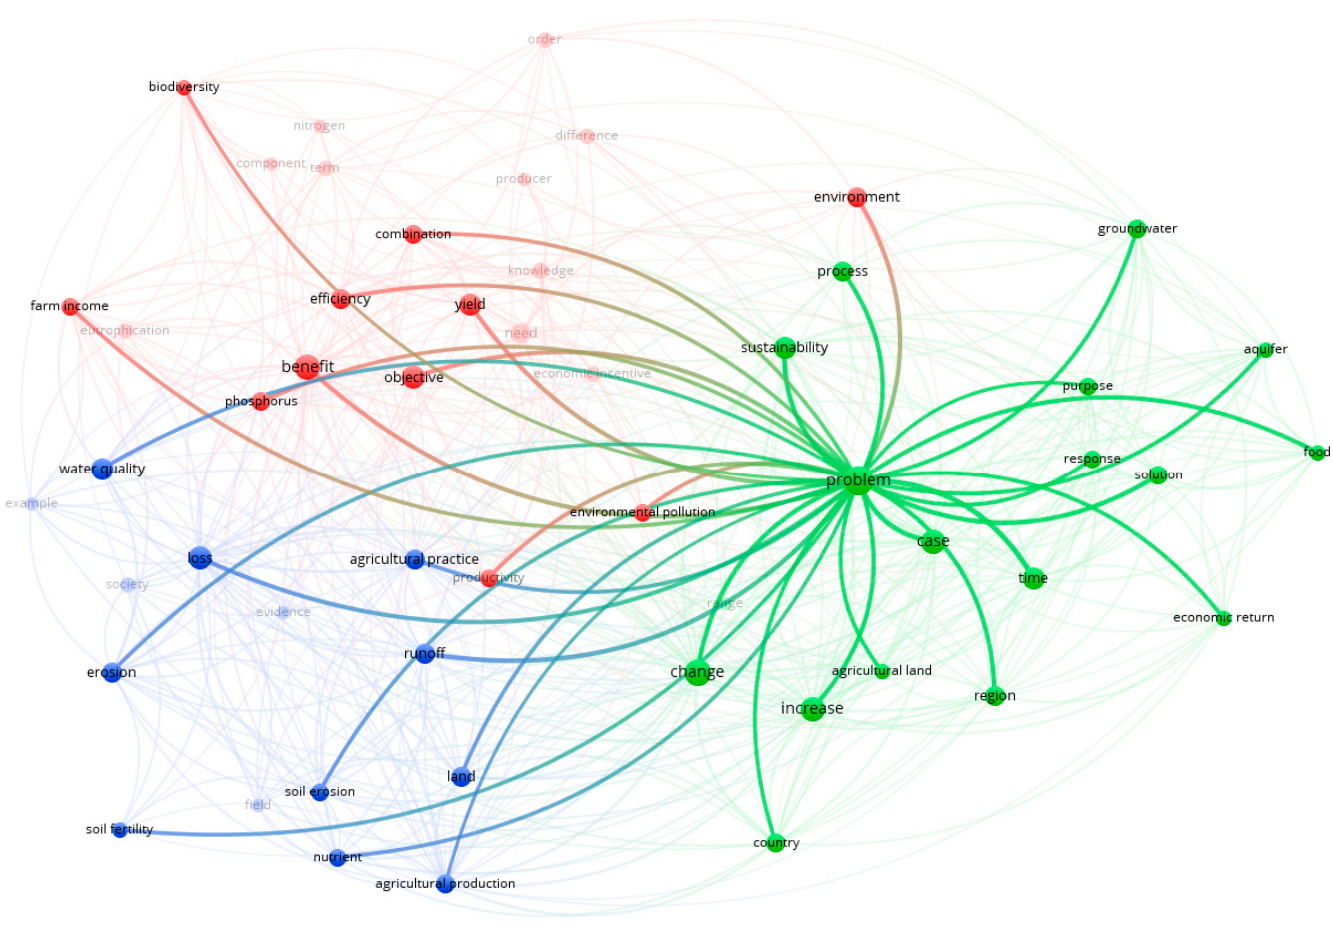
Figure 3. Interrelationships with the term “problem” from cluster 2.